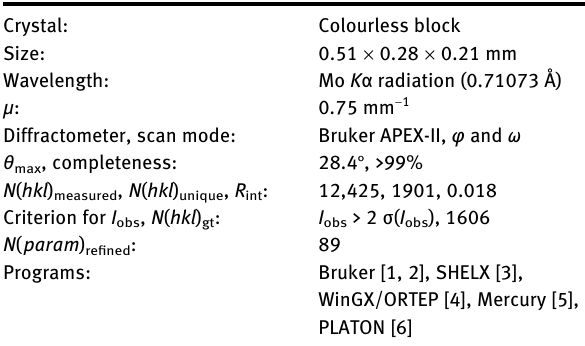
Table  : Data collection and handling.